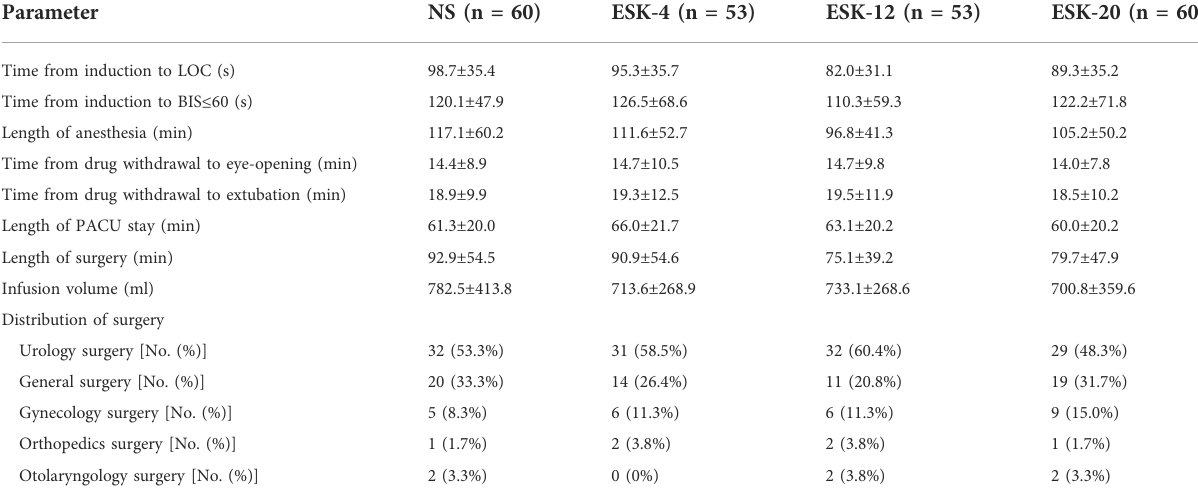
TABLE 3 Characteristics of anesthesia and